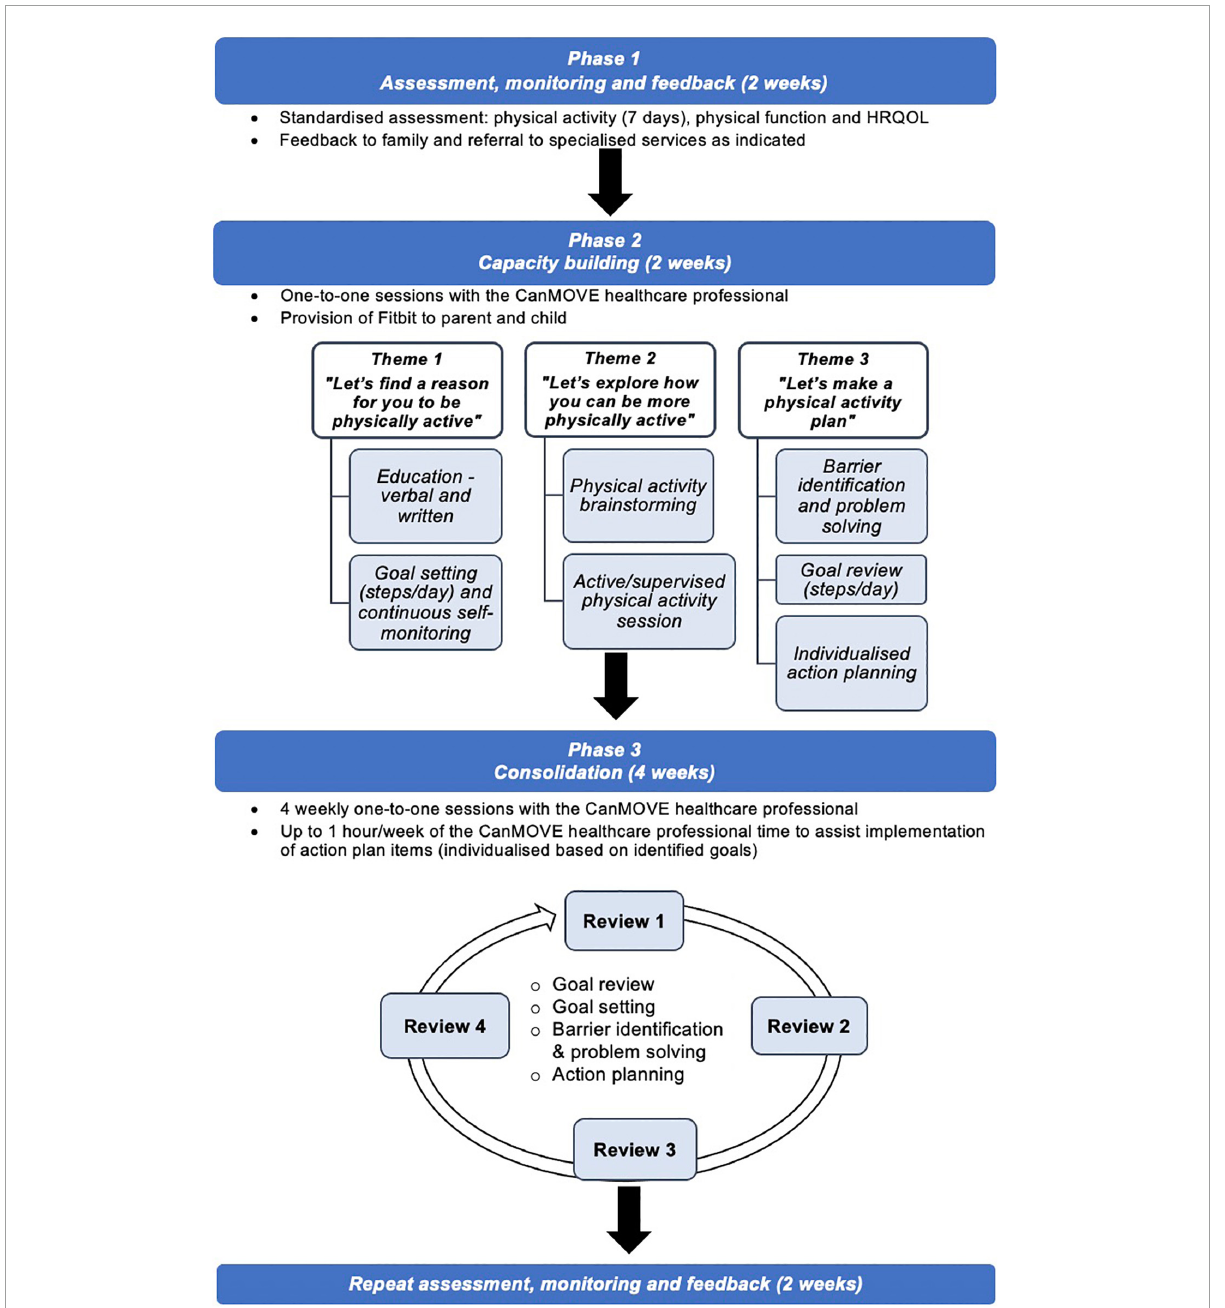
FIGURE2 CanMOVE intervention